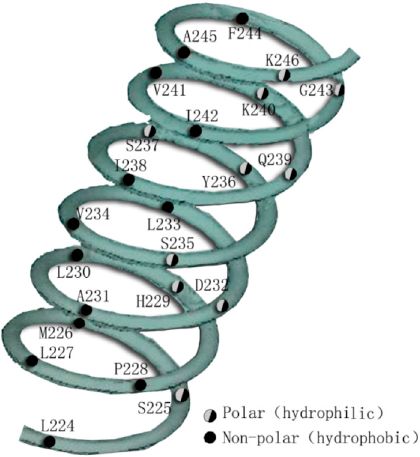
Figure 3. A continuous amphipathic H3 in the hVDR LBD. The polar/charged (hydrophilic) residues and non-polar residues (hydrophobic) occur on opposite faces of the helix.